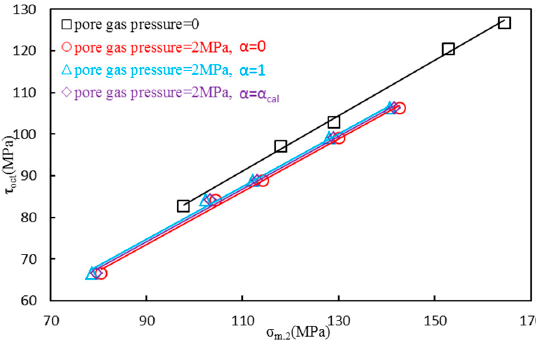
Figure 11. Measured strength data and curves fitted using the Drucker-Prager criterion.